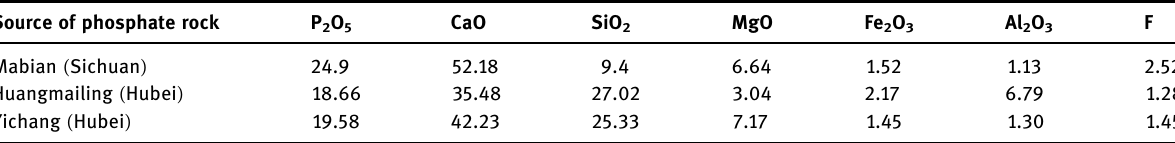
Table 1: Main chemical composition of phosphate rock % ( wt )